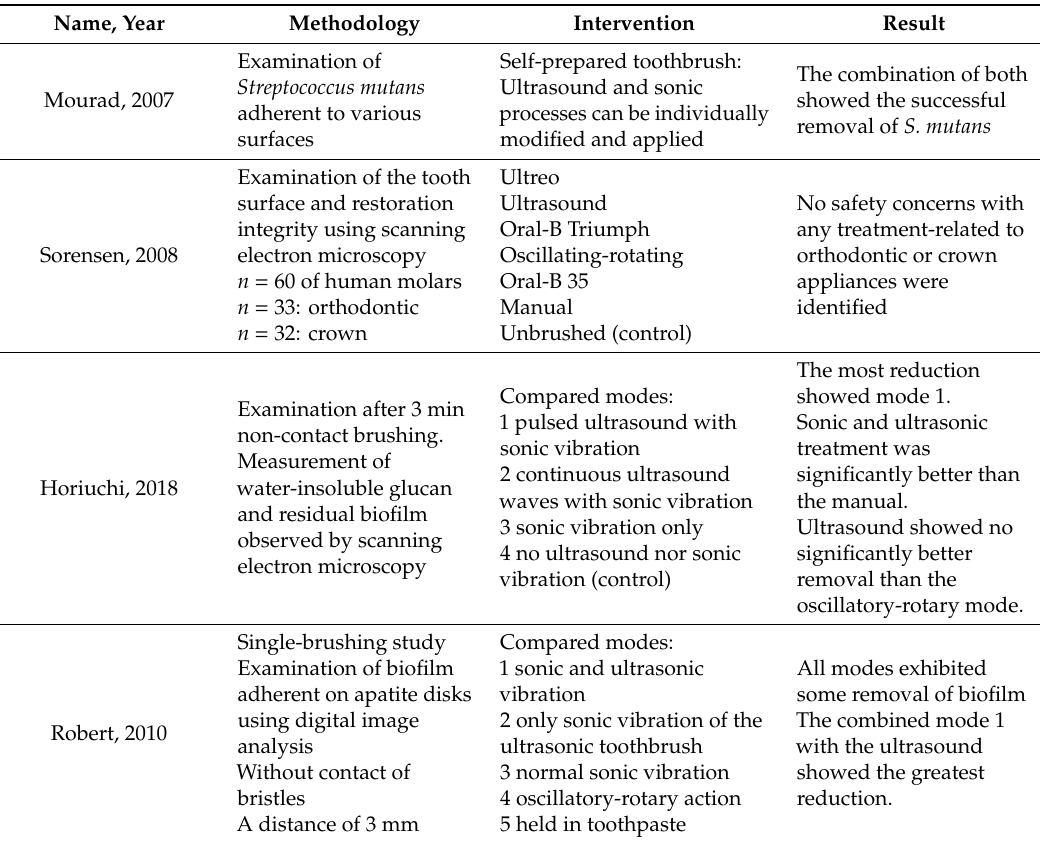
Table 4. In-vitro studies on the sonic toothbrushing e ff